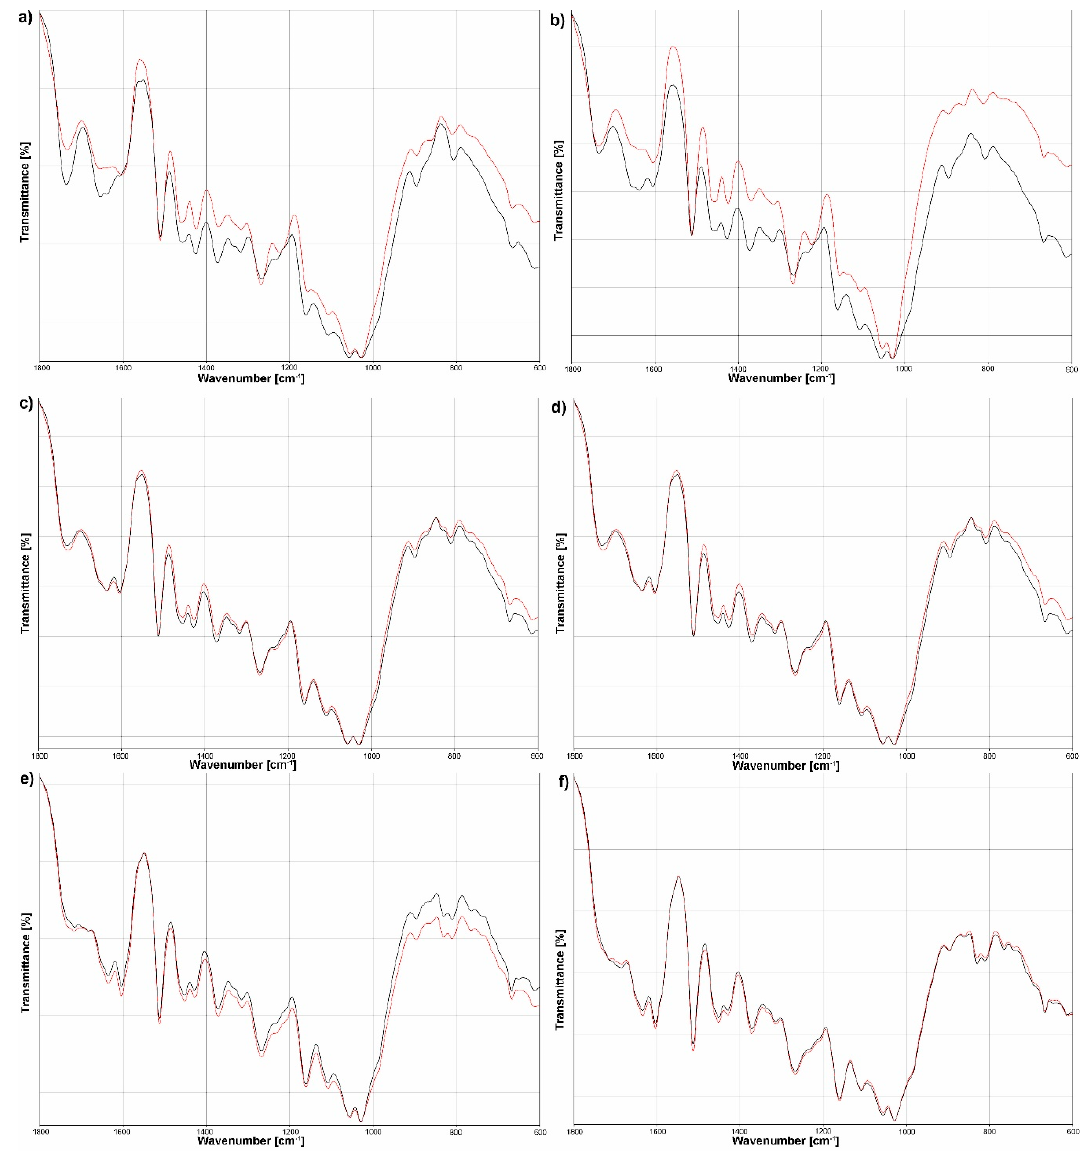
Figure 2. The Fourier Transform Infrared Spectroscopy (FTIR) spectra of the Scots pine wood before the exposure to C. puteana ( ― ) and after the exposure to C. puteana ( ― ): ( a ) untreated wood (control wood sample), ( b ) wood treated with the 3% propolis extract, ( c ) wood treated with the 7.5% propolis extract, ( d ) wood treated with the 12% propolis extract, ( e ) wood treated with the 18.9% propolis extract and ( f ) wood treated with the 30% propolis extract.